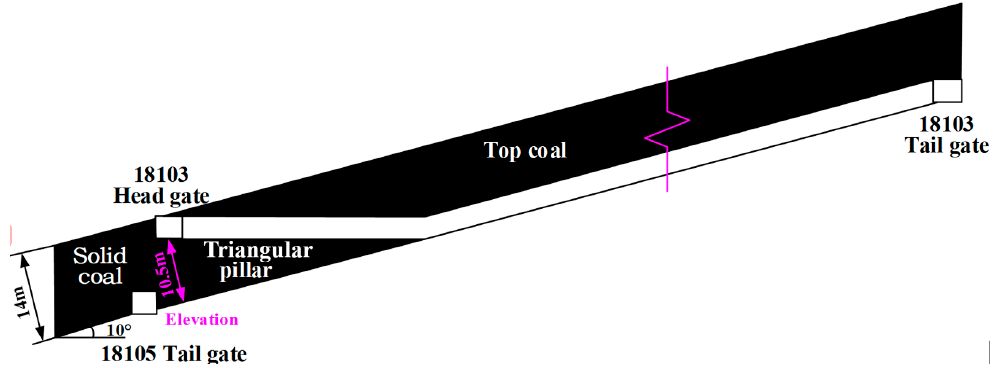
Figure 5. Layout with zero pillar at Xiegou mine.